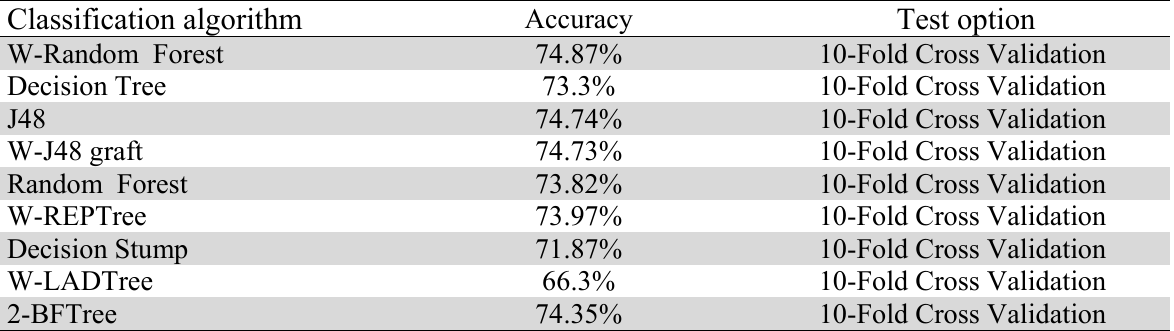
The summary of the algorithm used for the proposed method